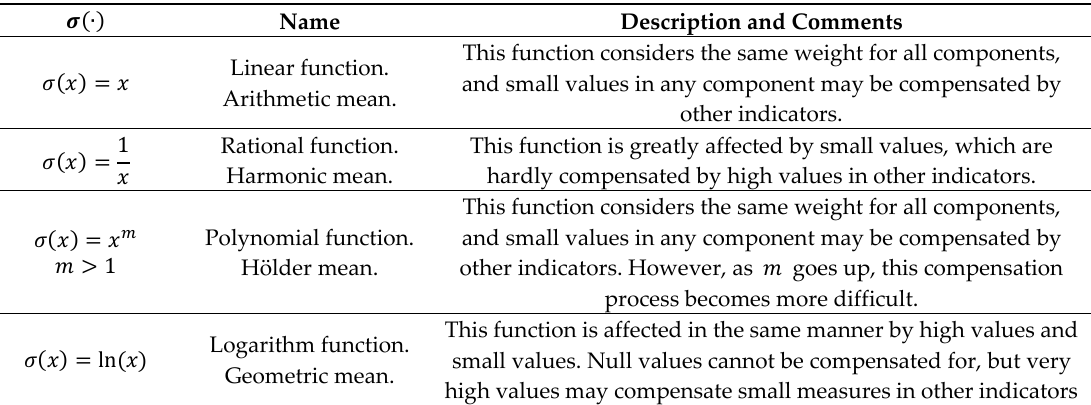
Table 1. Most relevant aggregation